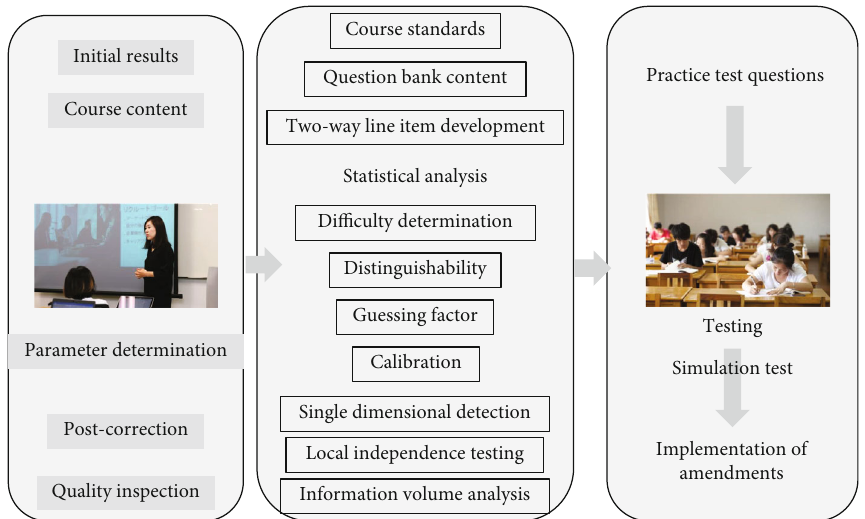
Figure 1: Steps of ELT